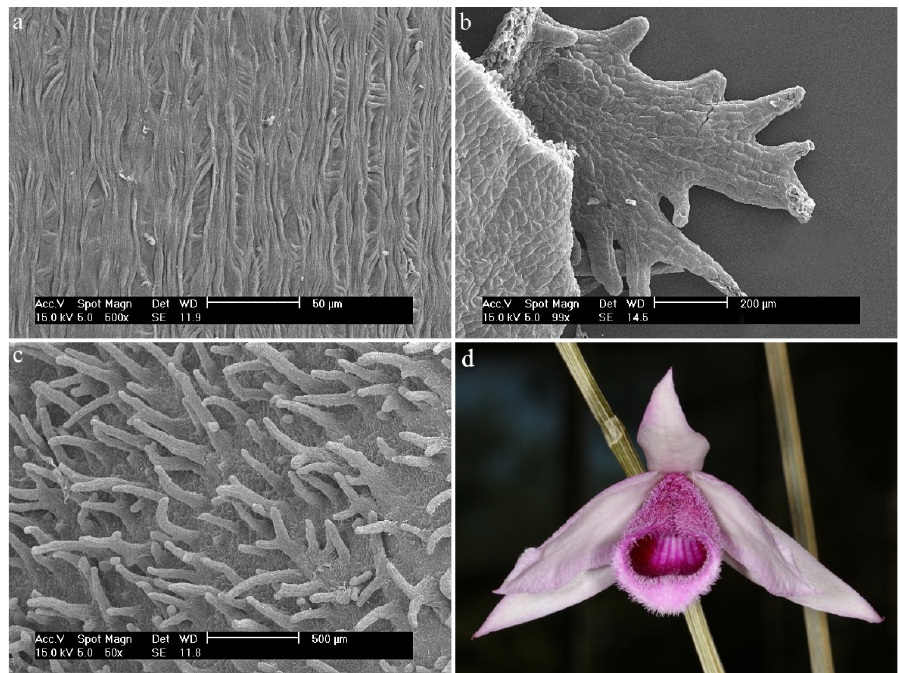
Figure 6. Dendrobium anosmum Lindl.: ( a ) the hypochile part of the labellum; ( b ) margin of the mesochile part of the labellum; ( c ) trichomes of the epichile part of the labellum; ( d ) flower (photo by John